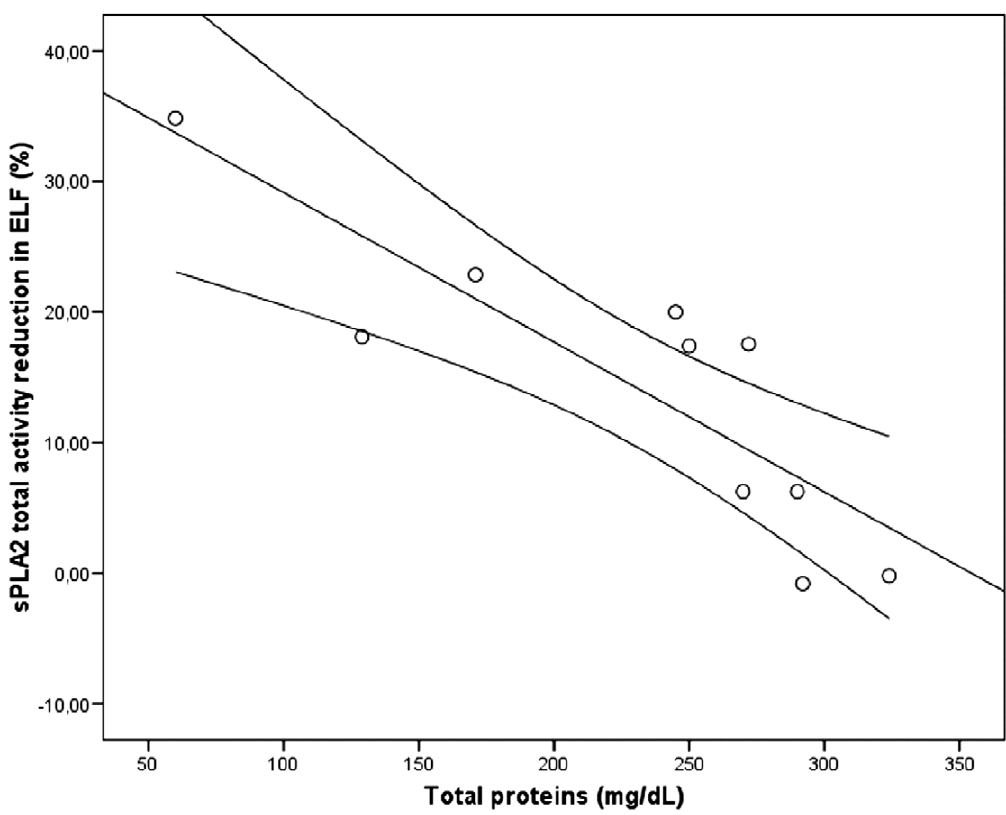
Figure 2. Negative correlation between the reduction of sPLA2 total activity and protein content. Grey lines represent linear regression line and its 95% confidence interval (rho=0.906; p , 0.001; R 2 =0.73).